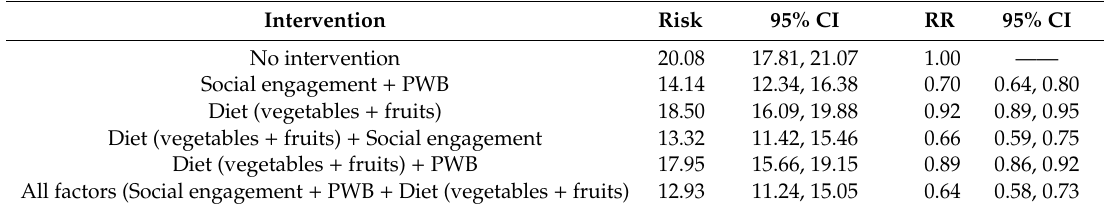
Table 3. Cognitive impairment risks under hypothetical joint